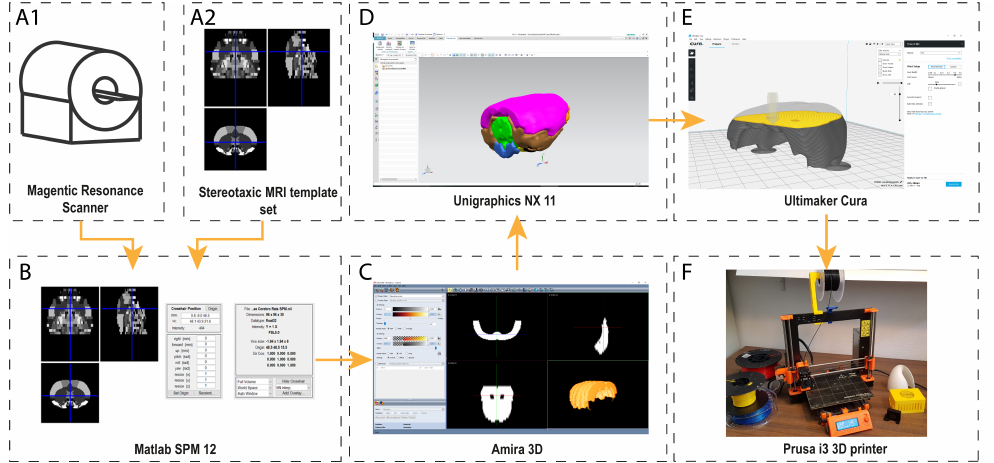
Figure 1. This figure shows the pipeline of the process from a CT or MRI set of images to a physical 3D printed model. First, images from a CT or MRI scanner ( A1 ) are colocalized with a stereotaxic template ( A2 ). Next, these images are clustered in Matlab SPM ( B ) to create the Voxels of Interest (VOI). With this set of images, a 3D reconstruction is created in Amira 3D software ( C ). Then, the 3D surface, which was created in Amira, is opened in a 3D design tool, e.g. Unigraphics NX, ( D ) where 3D surfaces are converted into 3D solid bodies. These solid bodies are provided with joins and connectors to add detachable properties to the 3D printed body. Once this process is complete, the manufacturing process starts ( E ). This consists of transforming the 3D body into a physical set of coordinates, which the 3D printer can interpret. In this case, a Prusa i3 MK2 3D printer with Cura software was used ( F ). The MRI template that was used is the one presented in [11]. Briefly, this template was created from multi-slice T2-weighted images of a rat brain acquired using a RARE sequence on a Bruker Avance 4.7-T MR scanner (Billerica, MA, USA) with the following acquisition parameters: RARE factor 8, matrix 256 × 256; FOV 40 mm, slice thickness 1 mm, 32 contiguous coronal slices; TReff = 5500 ms; TEeff = 76 ms. A 72-mm birdcage resonator was used for RF transmission and the Bruker quadrature FRat Brain_ coil was used for RF reception. The images were acquired in the coronal plane, centered 8 mm caudal from the posterior edge of the olfactory bulb [11]. Each region is marked with a different gray intensity. In total, 466 brain regions were clustered into 38 sub-regions and grouped into eight regions with the participation of an experienced neurobiologist. These parts correspond to the eight pieces of the printed rat brain that is presented in this paper (Table